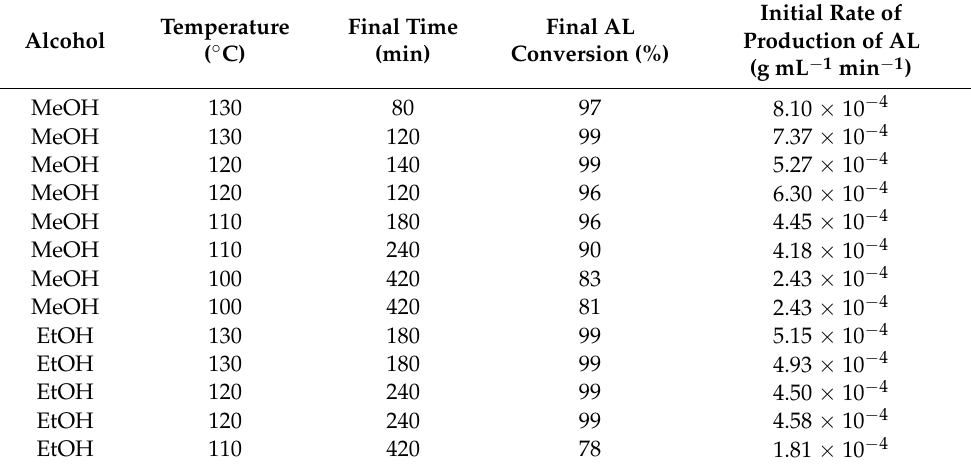
Table 3. PLA alcoholysis using MeOH and EtOH, 0.05 g of DMAP, and 0.05 g of ZnAc at 300 rpm. Table shows initial rate of production for AL and time taken to reach final AL conversion (%) at different